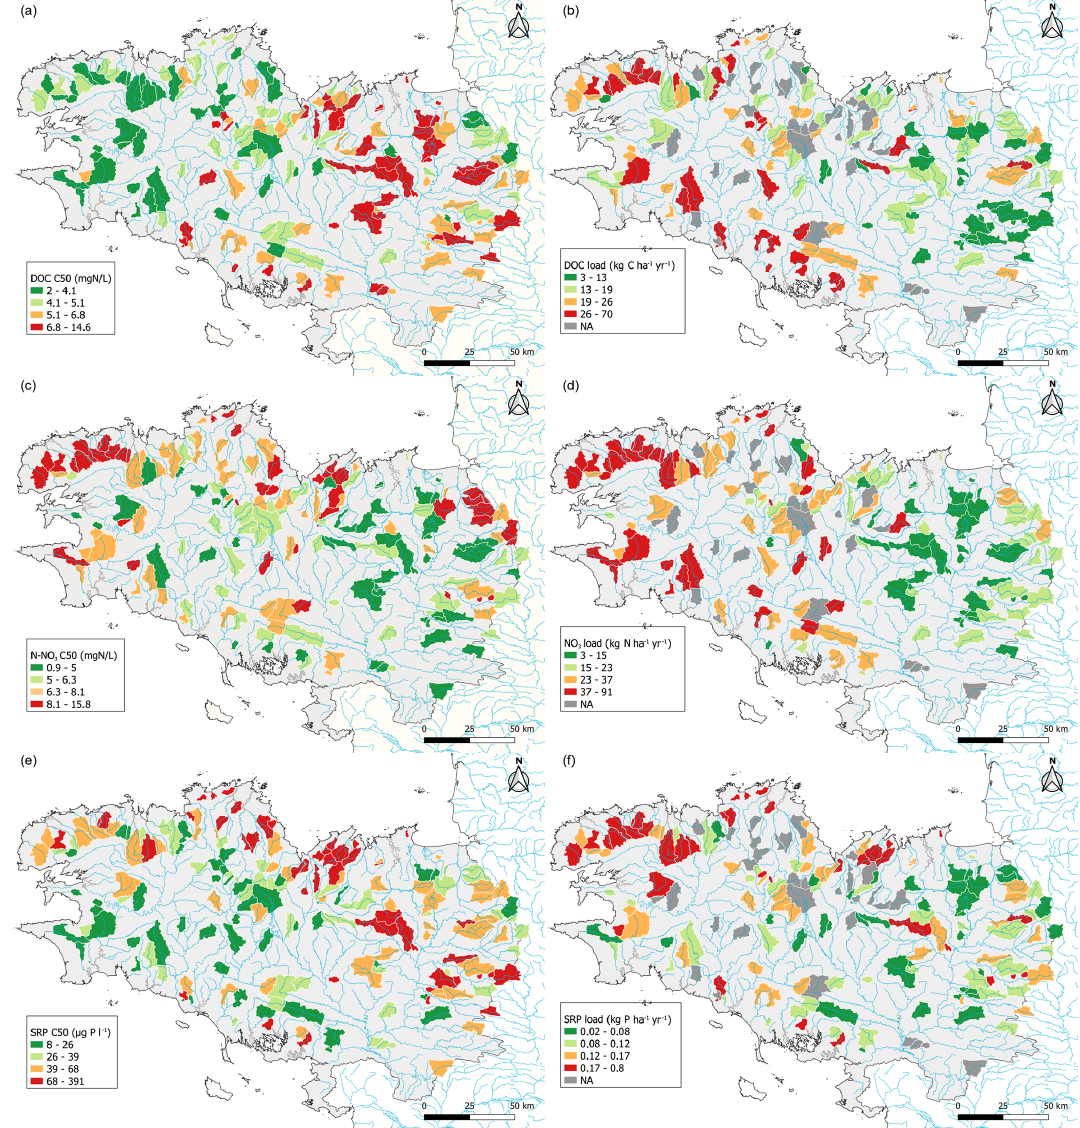
Figure 2. Map of median (a, c, e) concentrations C 50 and (b, d, f) loads of dissolved organic carbon (DOC), nitrate N (N-NO 3 ), and soluble reactive phosphorus (SRP) for the 185 streams. The catchments in grey did not meet the criteria to estimate a mean average interannual load. Classes in the legends have equal numbers of